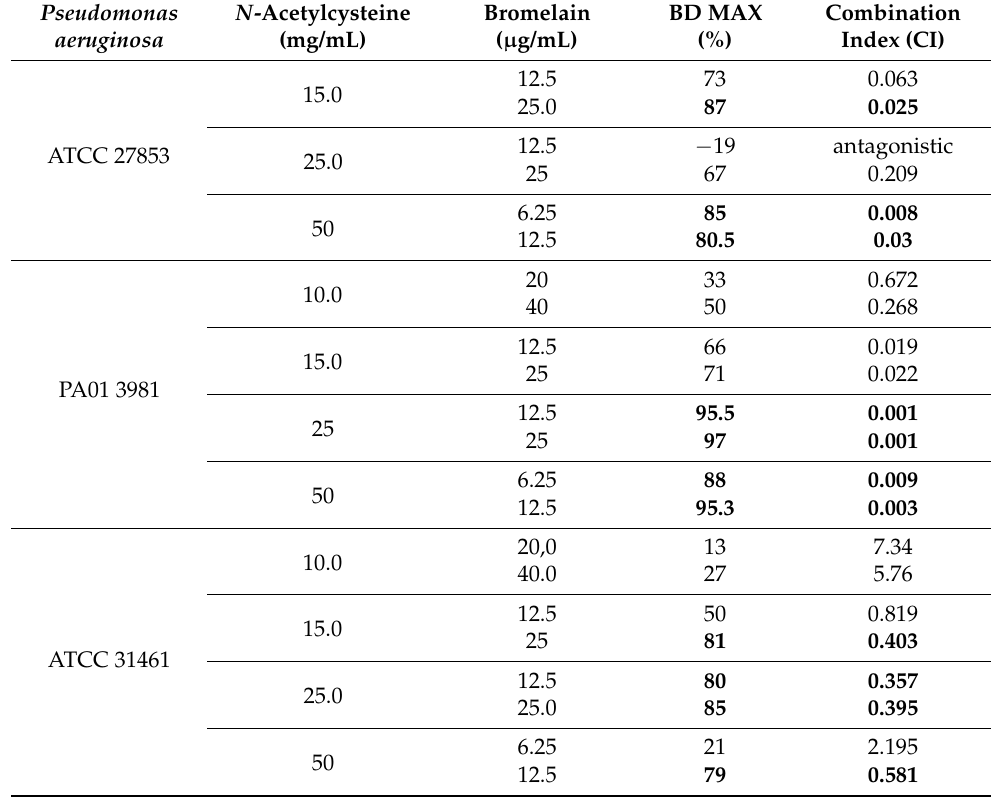
Table 2. The biofilm dissolution actions of individual agents and their combinations on the biofilm secreted by Pseudomonas aeruginosa ATCC 31461, PA01 3981, and ATCC 27853. Only values with p < 0.05 are shown in the tables. Additions of agents with significant effects are highlighted inbold font. Note: BD MAX (%): Maximum Biofilm Dissolution (%); Antagonistic: CI value >